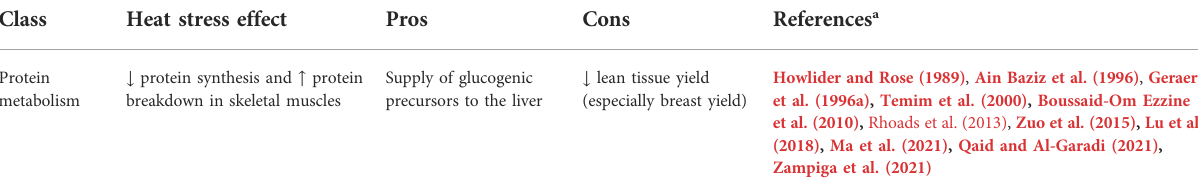
TABLE 3 Overview of heat stress effects on skeletal muscle protein metabolism of